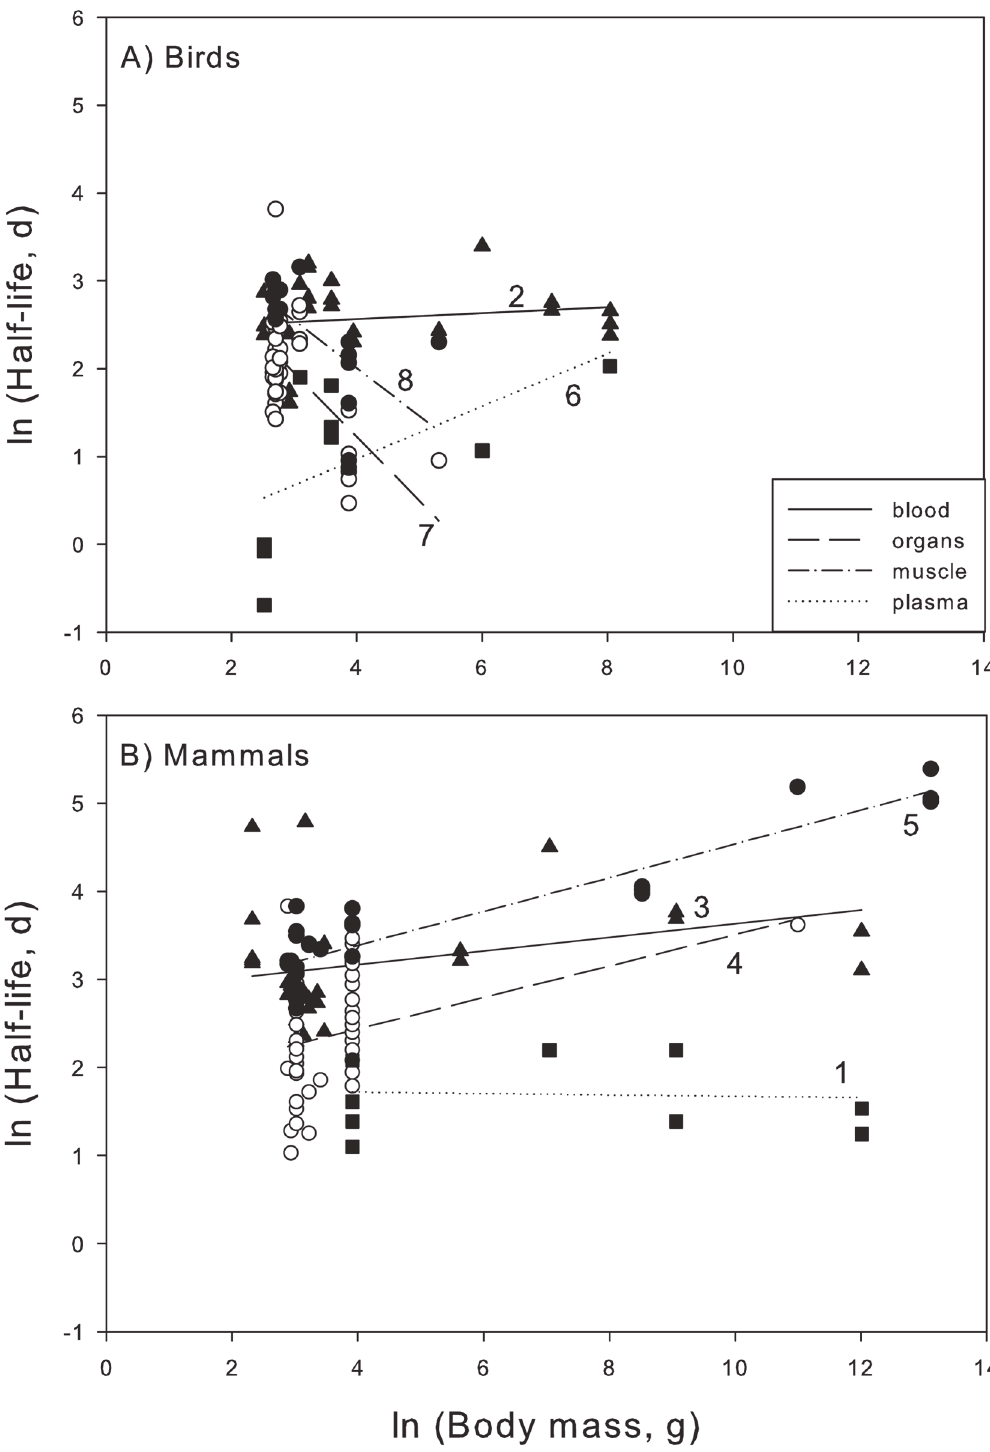
Fig 4. Relationships between ln(body mass) and ln(half-life) for tissue types in A) birds and B) mammals. Numbers correspond with Table 4. Symbols: filled triangles = blood; open circles = organs, filled circles = muscle, filled squares = plasma.